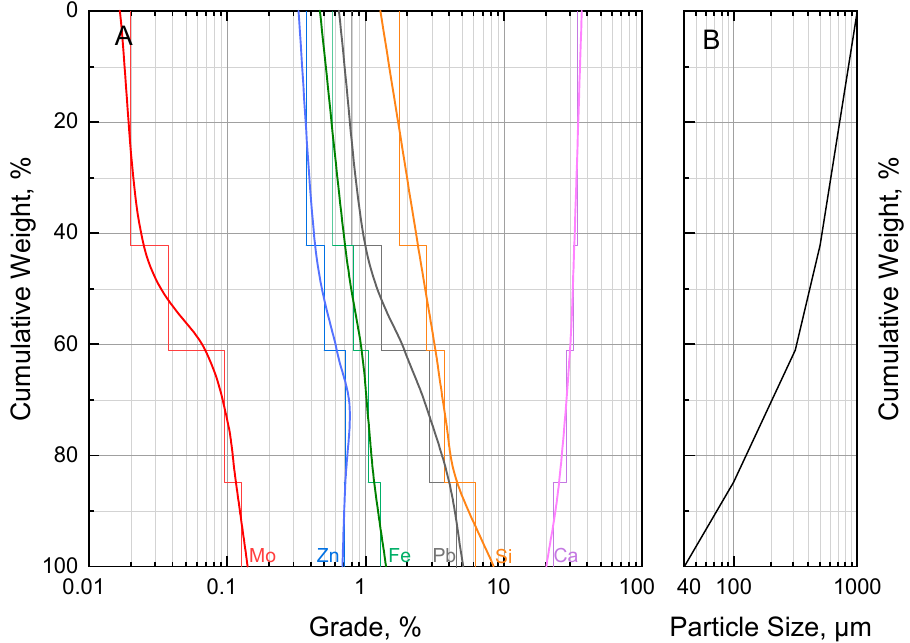
Figure 8. Characteristic curves of the Henry–Reinhardt-plot ( A ) shows the distribution of elements according to particle size. Note: Correct area replacement requires linear grade-axis. Particle size distribution ( B ).